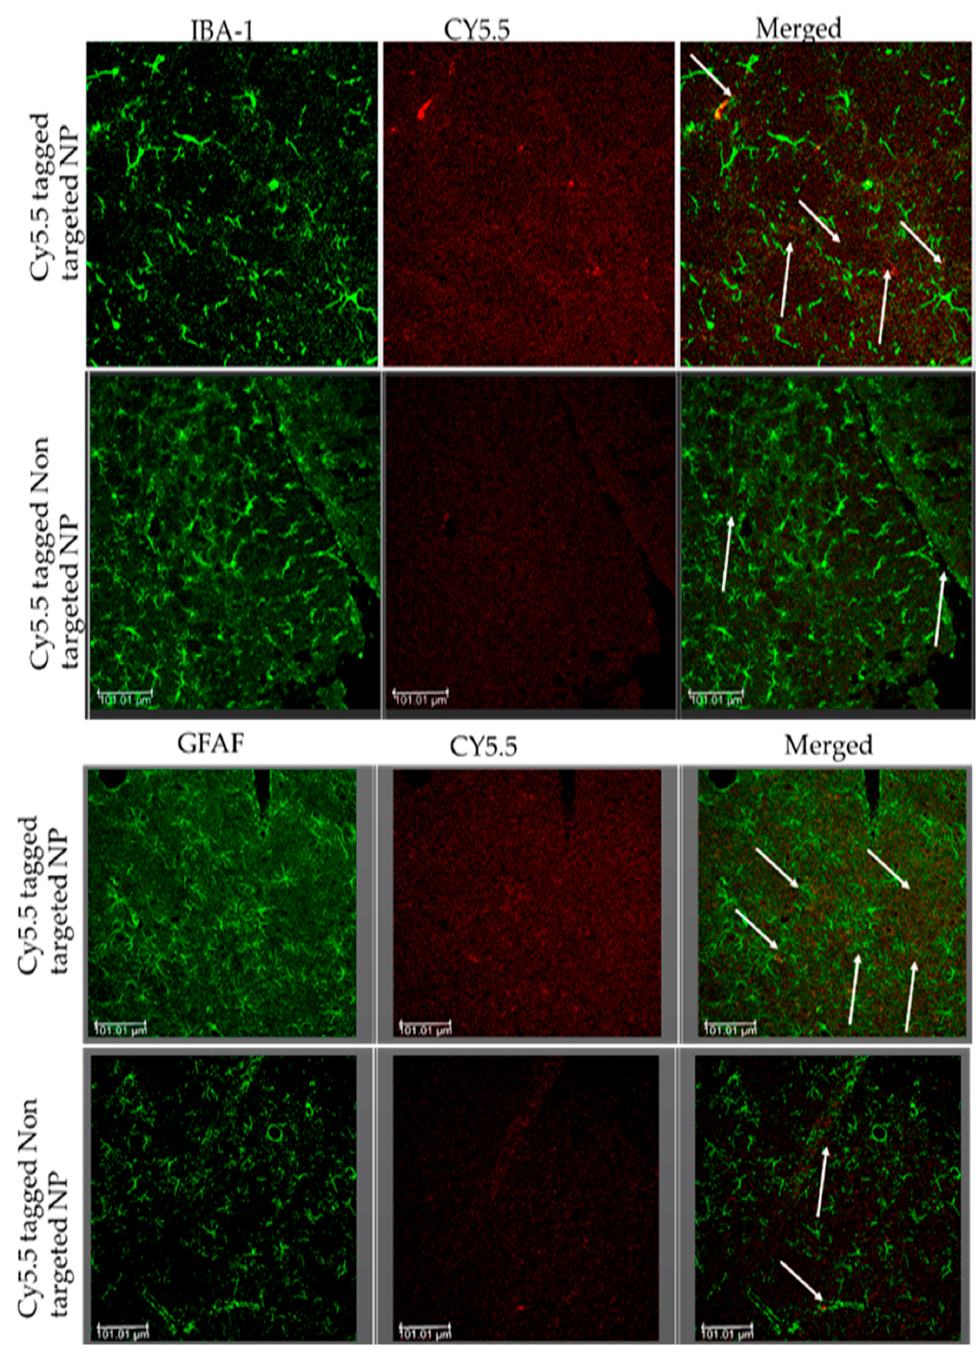
Figure 11. Nanoparticles internalized in the parenchyma and glial cells of the brain by crossing the BBB and via active targeting using transferrin receptors. The bTBI rats were intravenously injected with Cy5.5-conjugated apoANPs and tf-apoANPs and then sacrificed 6 h after the injection. The brain tissues were collected from 6 h after injections of Cy5.5-conjugated apoANPs and tf-apoANPs. The sections were observed under a confocal microscope. The distribution in the brain parenchyma and uptake of Cy5.5-conjugated apoANPs and tf-apoANPs (white) by the microglia and astrocytes are shown. Scale bar = 100 μ m.